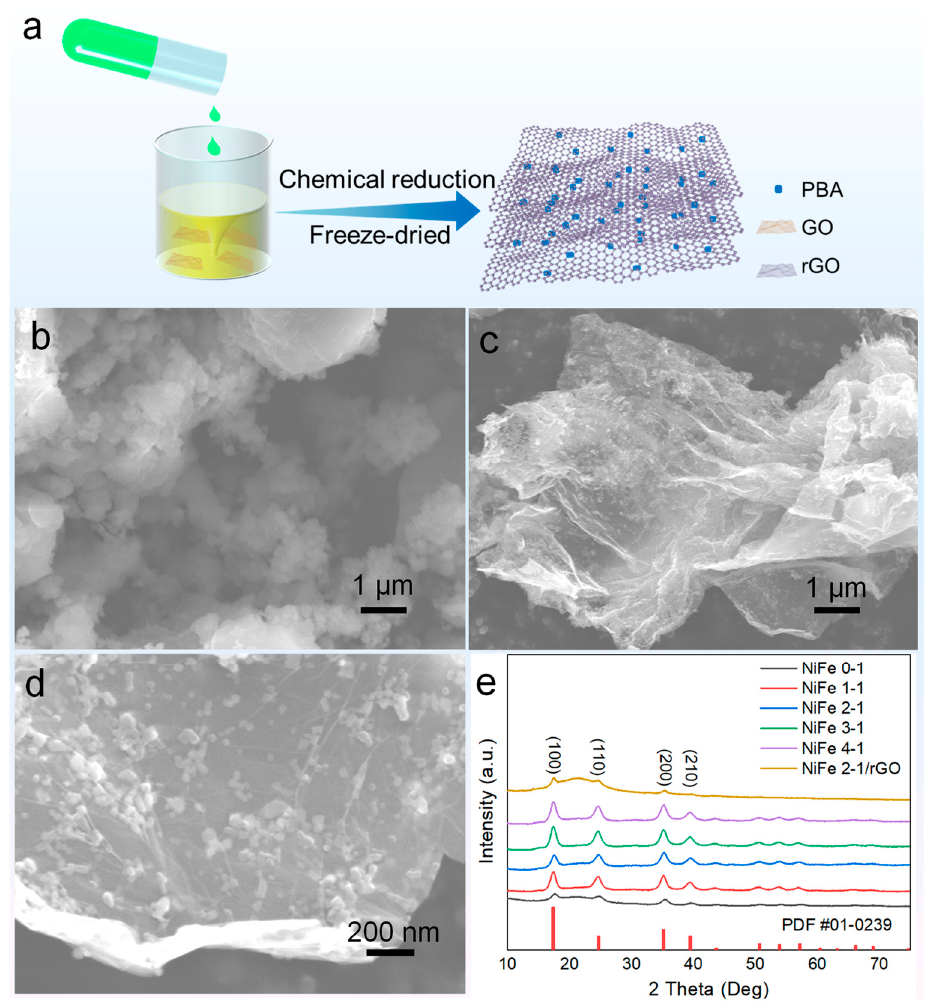
Figure 1. ( a ) Schematic illustration of preparation process; ( b ) SEM images of PBA NiFe 2-1; ( c , d ) SEM images or PBA NiFe 2-1/rGO at various magnification; ( e ) XRD patterns of the as obtained PBA samples.